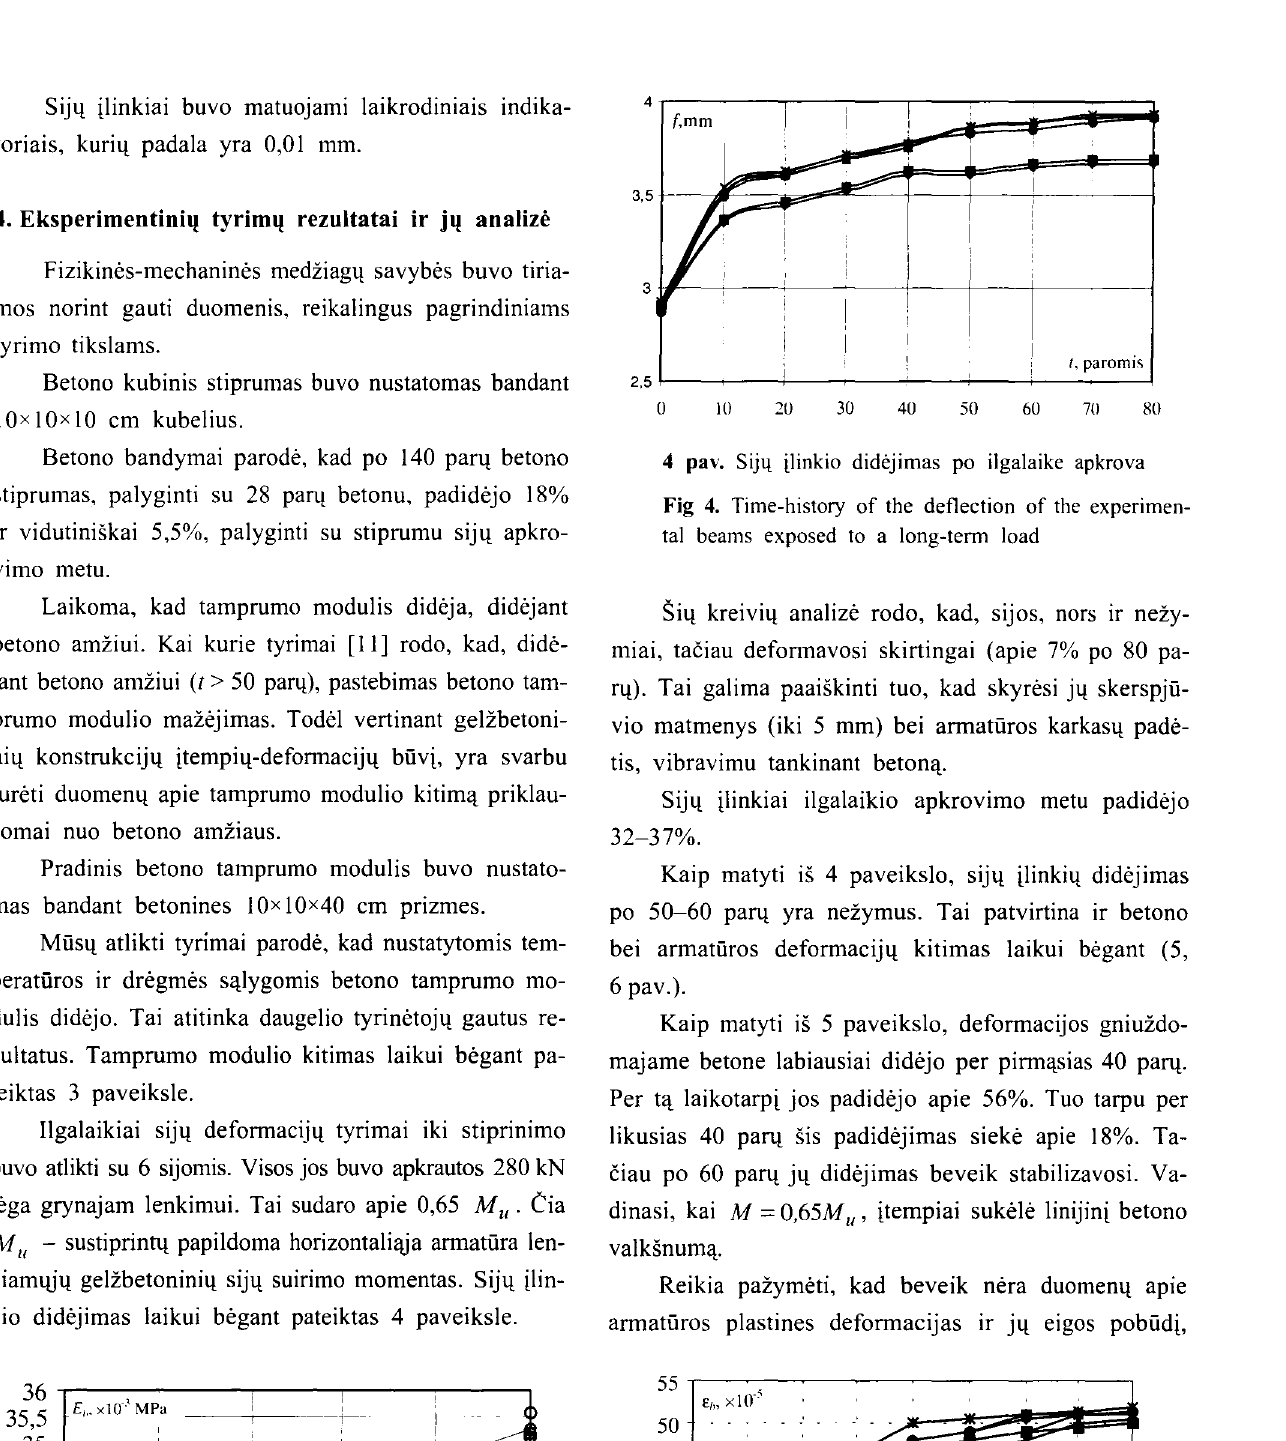
Fig 3. Time-history of concrete elasticity modulus